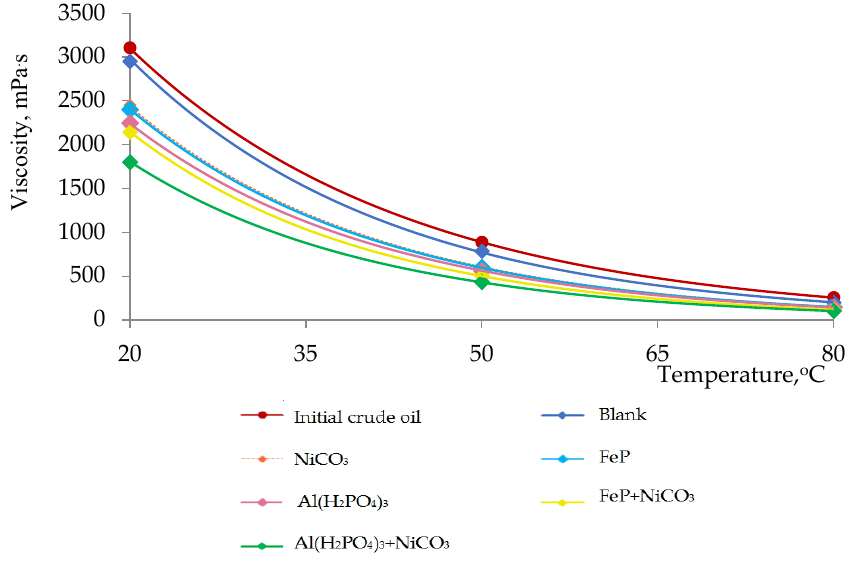
Figure 1. Pressure changes during thermolysis at 250 °C.